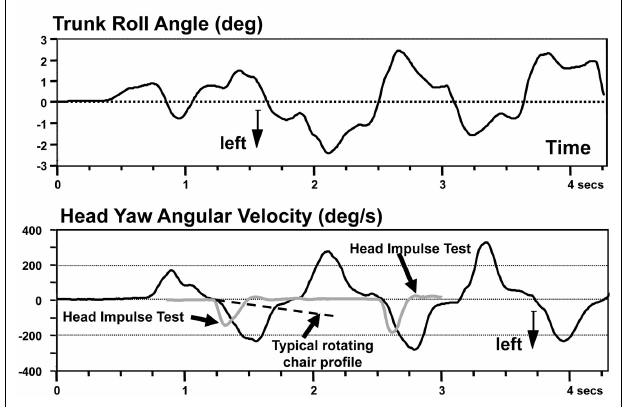
FIGURE 1 | Comparison of head velocities during a gait test with those from a head impulse test (HIT) and a typical rotating chair velocity profile. The upper trace shows the lower trunk roll movements during walking while rotating the head left and right in pace with gait.The lower trace shows the head velocity in comparison to two HIT records and one rotating chair record. Although the amplitude of head velocity is comparable in the HIT test, the accelerations are clearly faster for the HITs, slower for the rotating